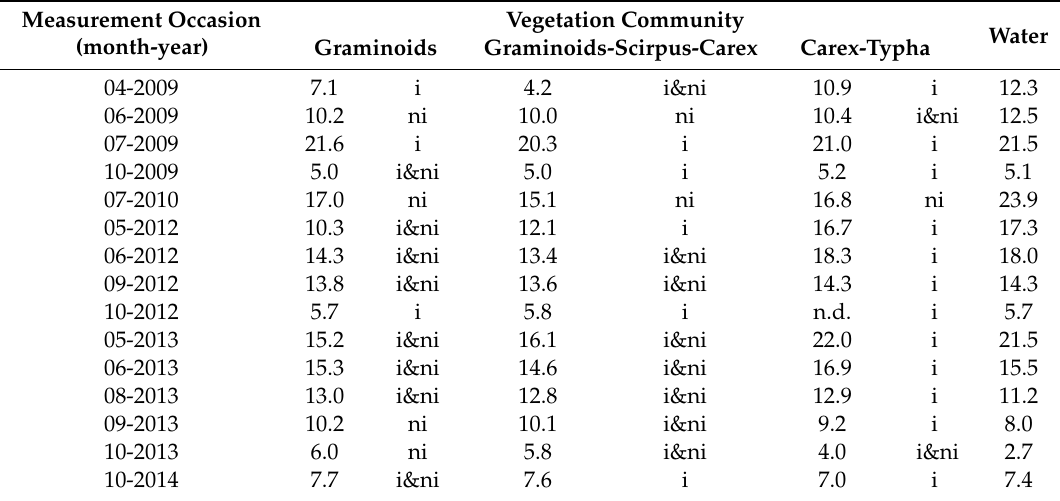
Table 2. Mean soil and water temperatures in ◦ C at 10 cm depth and water level categories at the study transects; i = inundated; ni = non-inundated; i&ni = partially inundated; n.d. = not determined.